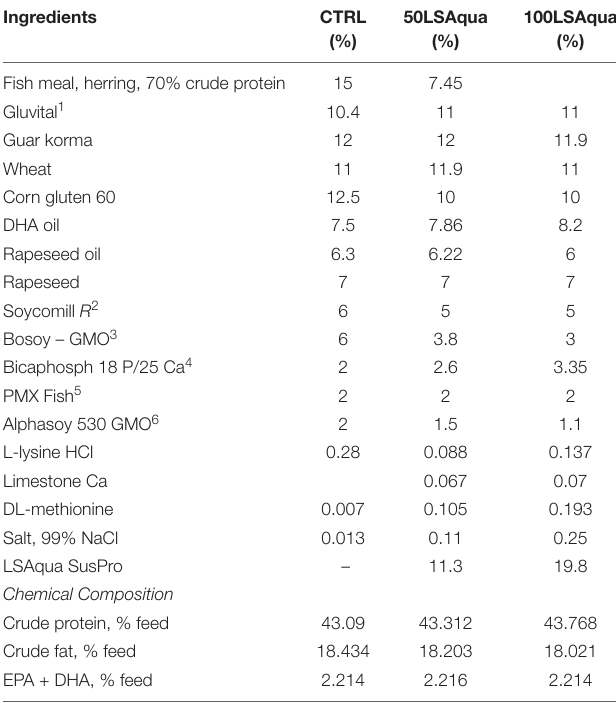
TABLE 1 | Ingredients and chemical composition of experimental diets.